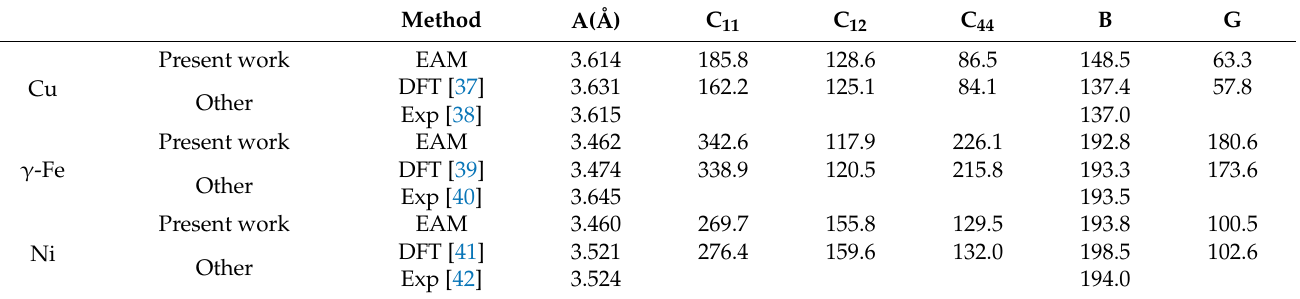
Table 1. Calculated lattice parameters, elastic constant (GPa), bulk modulus B (GPa), and